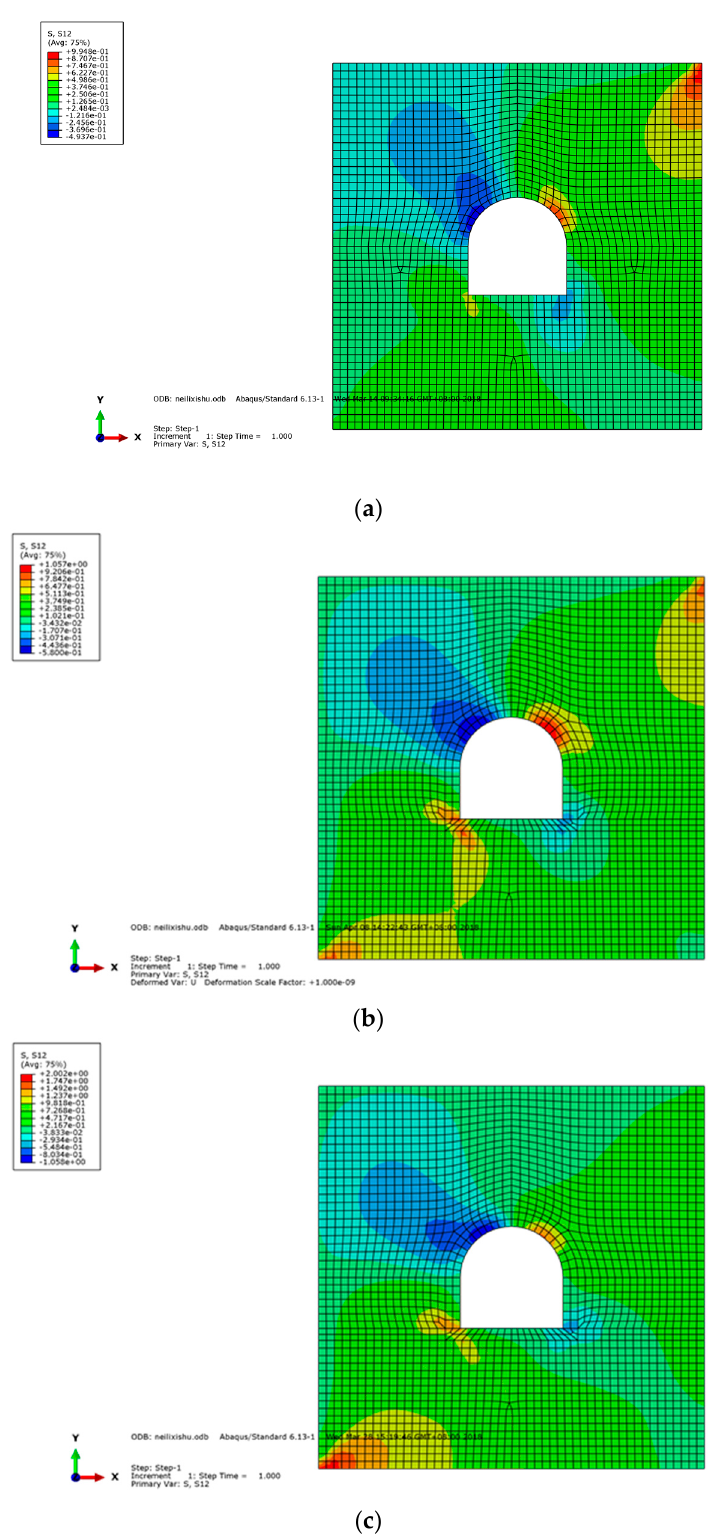
Figure 3. Shear coefficient of the tunnel under different lateral pressure coefficients. ( a ) when λ = 0.5, ( b ) when λ = 1, ( c ) when λ = 2